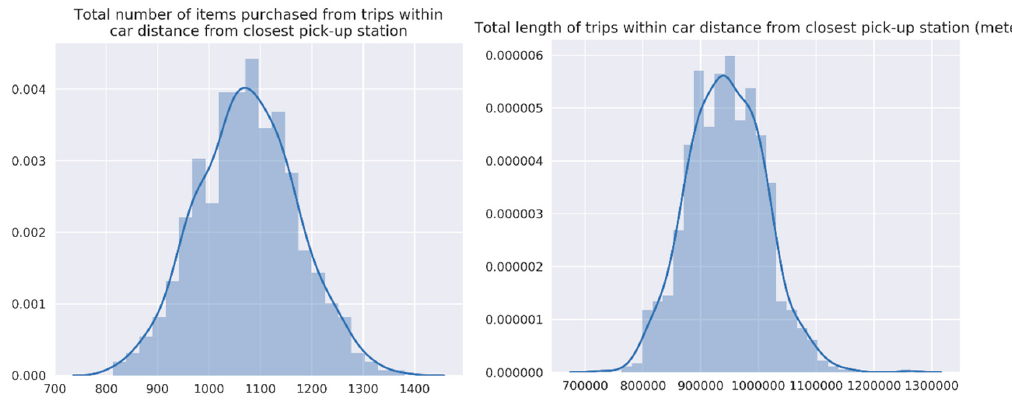
Figure 7. Total number of purchases from trips within car distance.